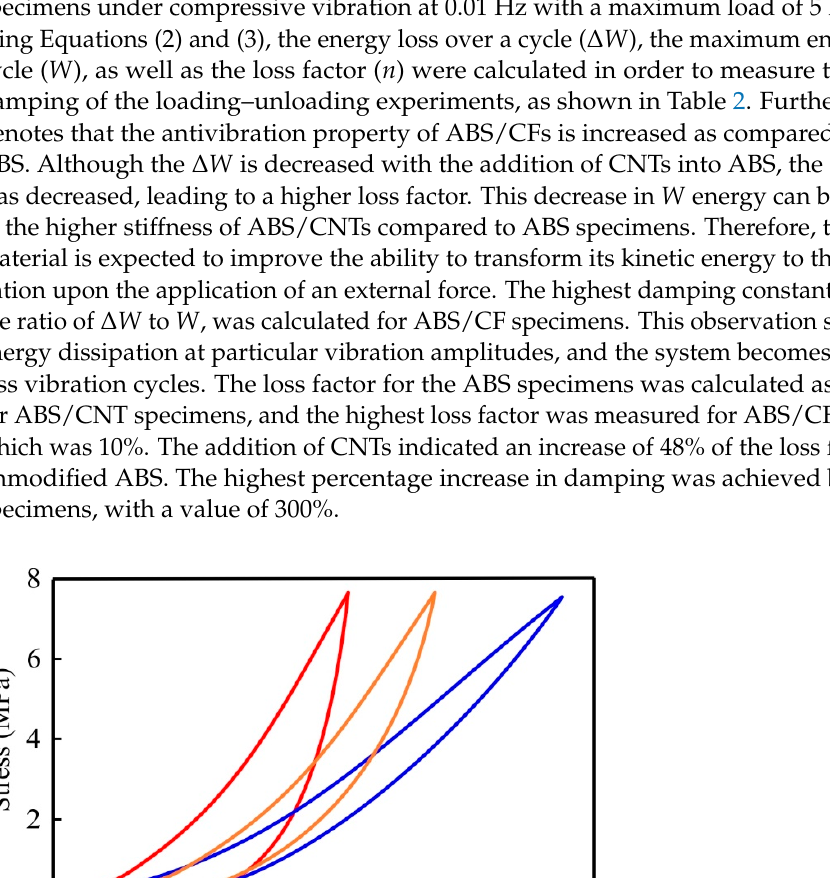
Table 2. Hysteretic damping properties of the ABS, ABS/CNT and ABS/CF FFF printed specimens.